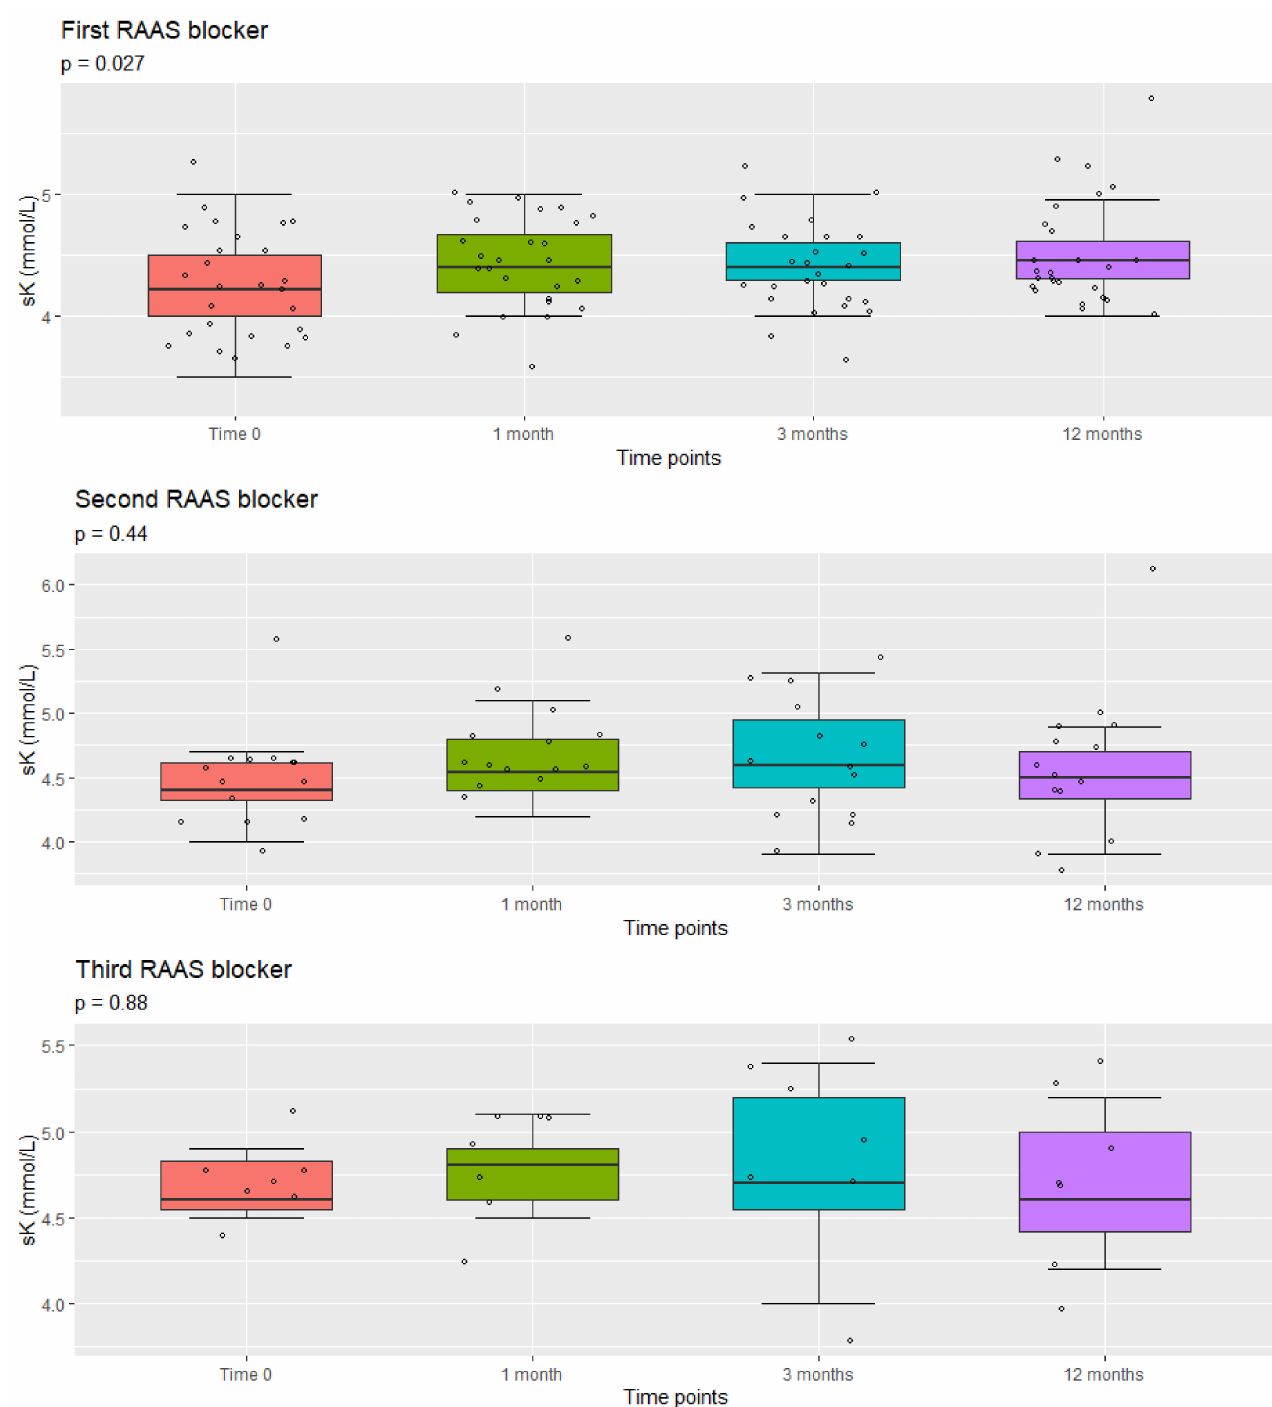
Figure 4. Boxplots of the distribution of sK values at different time points from the introduction of the first, second, and third RAAS blocker. All p values are from Repeated Measures Anova